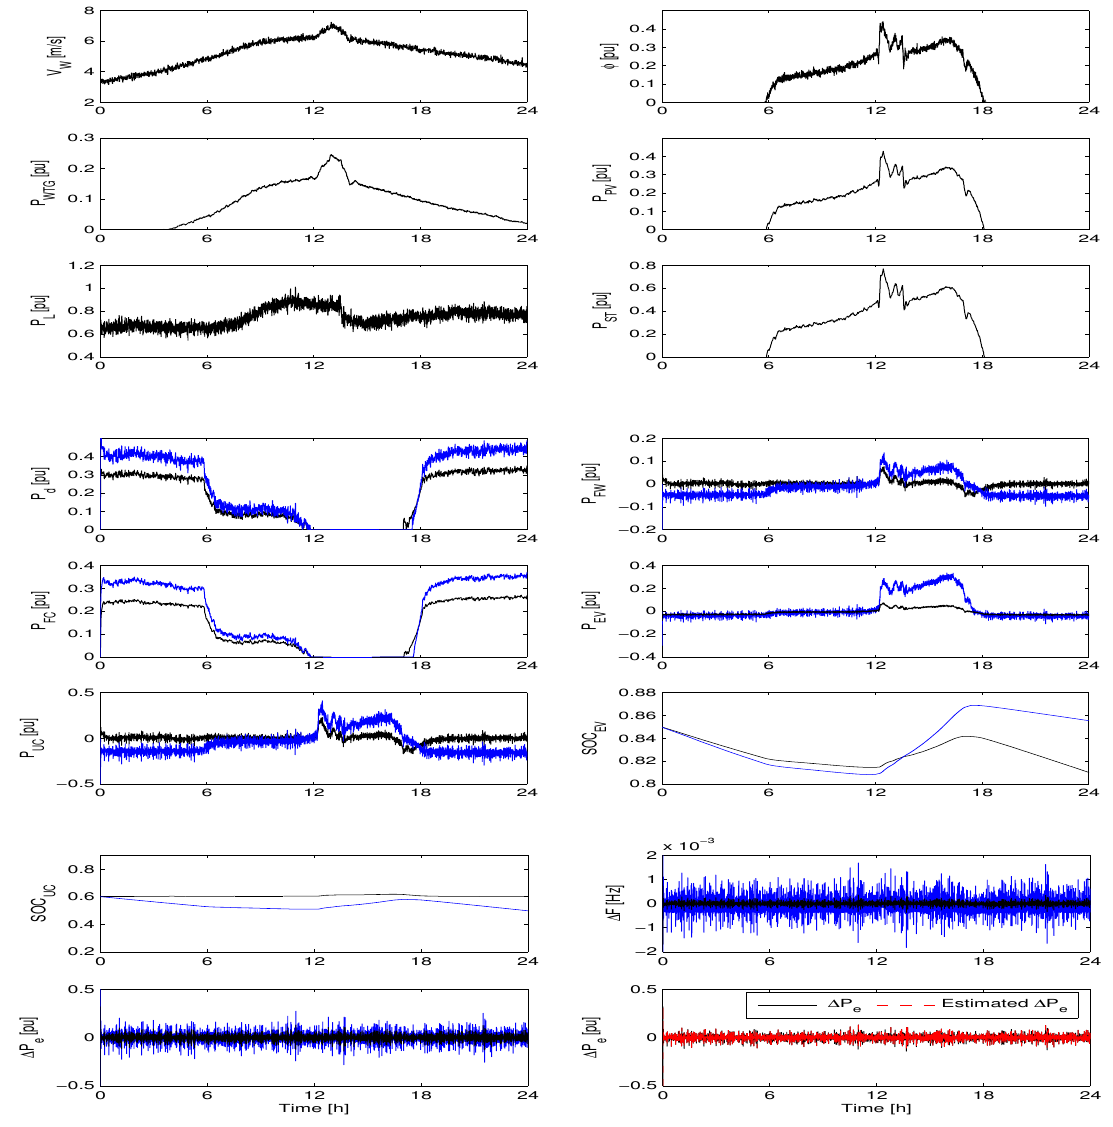
Figure 17. Case 3 simulation results: PF (black), FLC